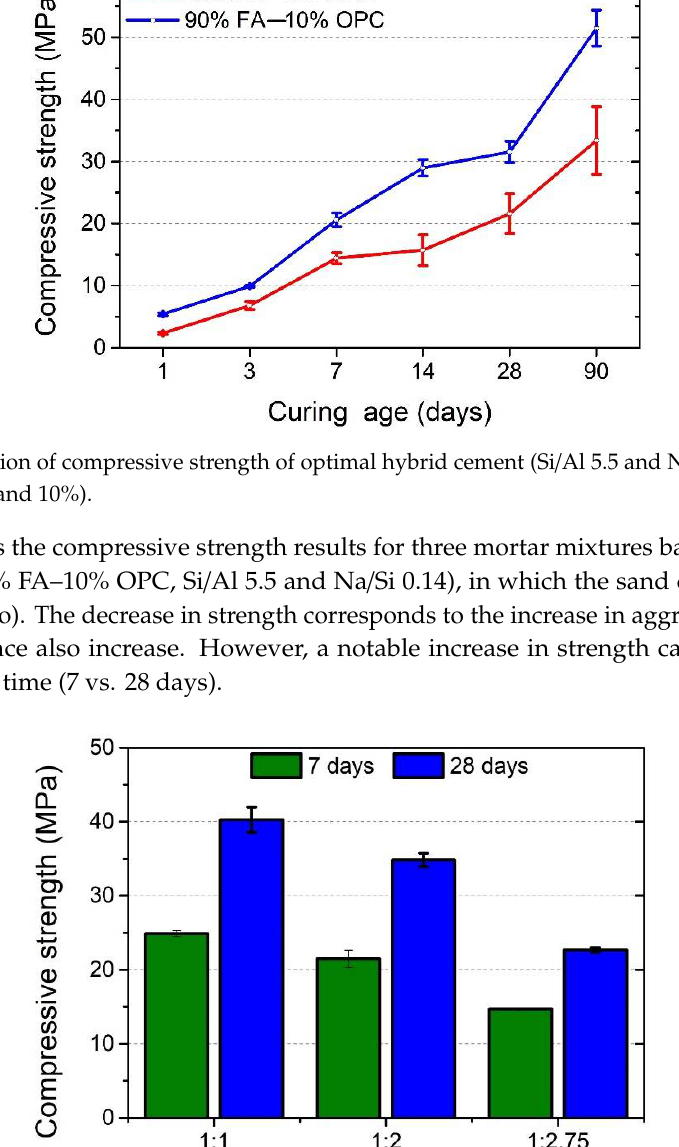
Table 5. Compressive strength required by the ASTM C1157 (NTC 121) standard for a LH type cementitious material and results obtained by the 1:2.75 hybrid mortar (90% FA–10% OPC).